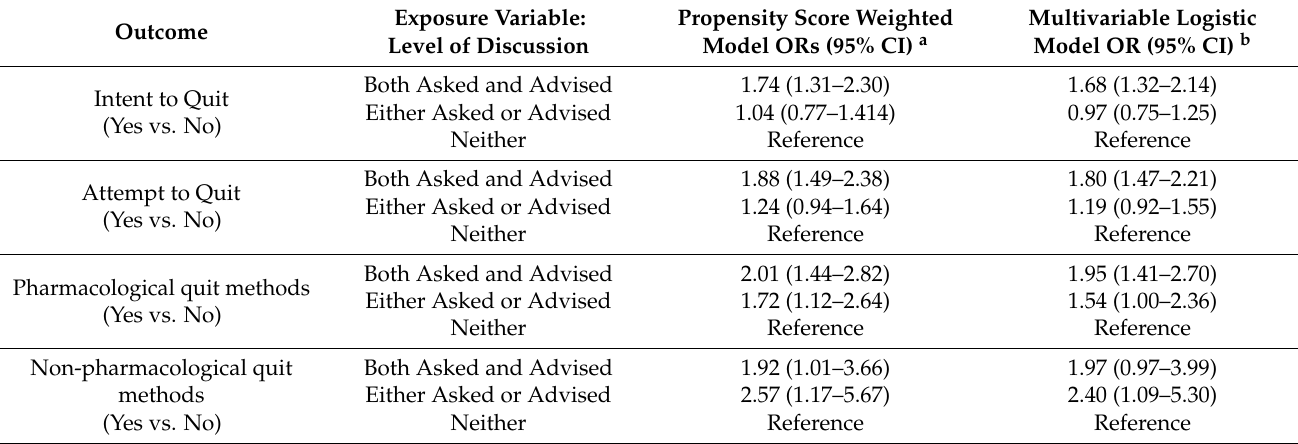
Table 3. The association between provider–patient discussion and quit behavior from a propensity score weighted model and a multivariable logistic